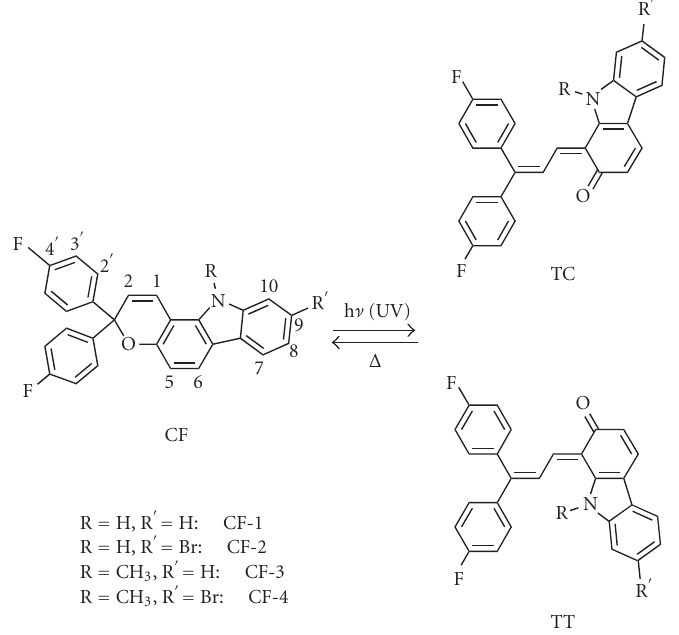
Scheme 1: Photochromic